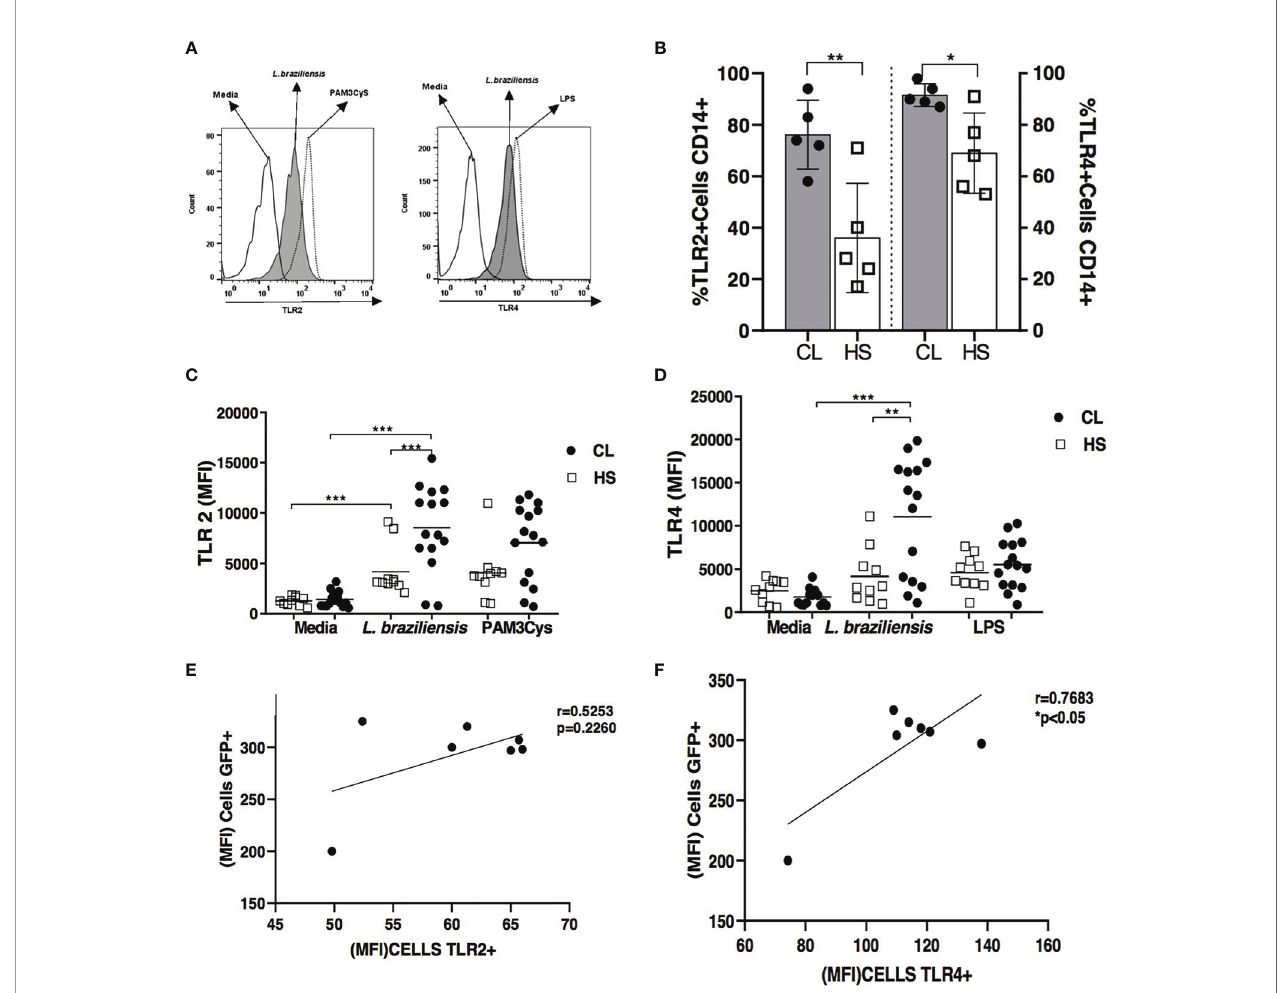
FIGURE 1 | TLR2 and TLR4 expression in L. braziliensis -infected monocytes from cutaneous leishmaniasis patients and healthy subjects. Monocytes in PBMC from CL patients (n = 15) and HS (n = 10) were infected with L. braziliensis (5: 1) for 2 hours and then the cells were labeled with anti-CD14 antibodies for the characterization of monocytes. Figure (A) shows the representative histogram from TLRS expression in CL patients. Frequency of TLR2 and TLR4 receptors in in the same CD14+ cells is showed in Figure (B) MFI of TLR2 and TLR4 in CD14 + infected cells are presented in fi gure (C) and (D) As a positive control of infection, Pam3Cys (TLR2 agonist) and LPS (TLR4 agonist) were used. Receptor expression was performed by fl ow cytometry. All p values were obtained using the Mann Whitney and Wilcoxon signed-rank test *p < 0.05, **p < 0.01 and ***p < 0.001. The Pearson correlation analyses was performed between GFP MFI and TLR2 (E) and TLR4 (F)